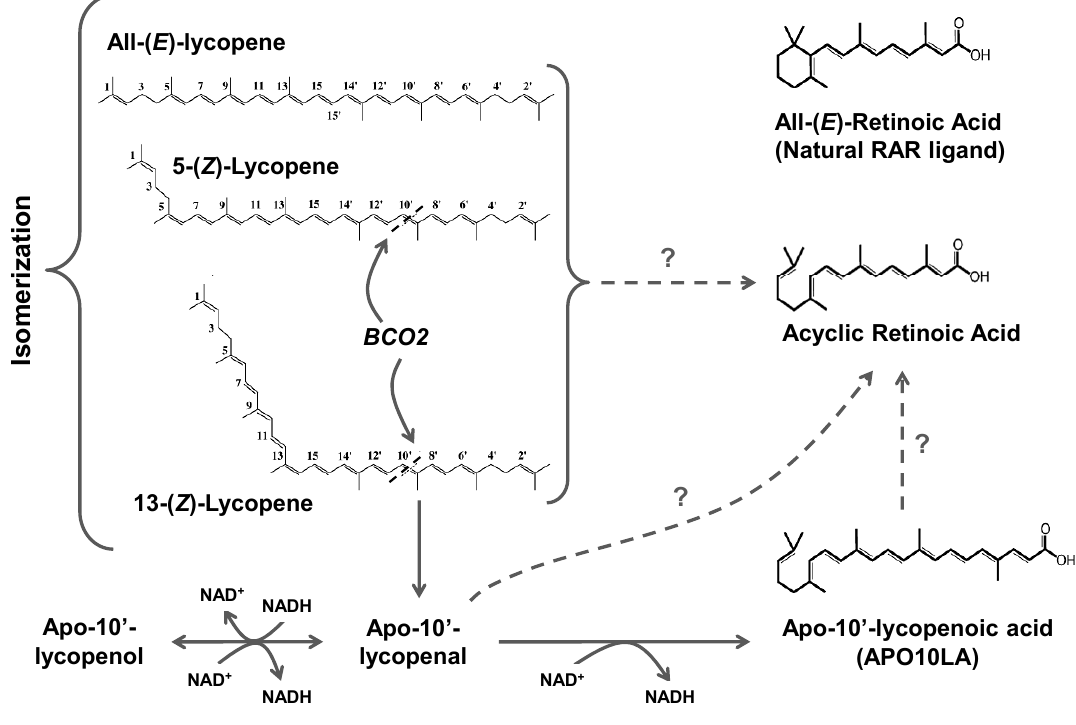
Figure 3. Schematic illustration of lycopene metabolic pathway by β carotene-9 ′ ,10 ′ - oxygenase (BCO2). 5-( Z ) and 13-( Z ) lycopene are preferentially cleaved by BCO2 at 9 ′ 10 ′ -double bond. The cleavage product, apo-10 ′ -lycopenal, can be further oxidized to apo-10 ′ -lycopenol or reduced to apo-10 ′ -lycopenoic acid (APO10LA), dependent on the presence of NADH. Whether apolycopenoids can be oxidized to form acyclic retinoids remains to be elucidated. RAR, retinoic acid